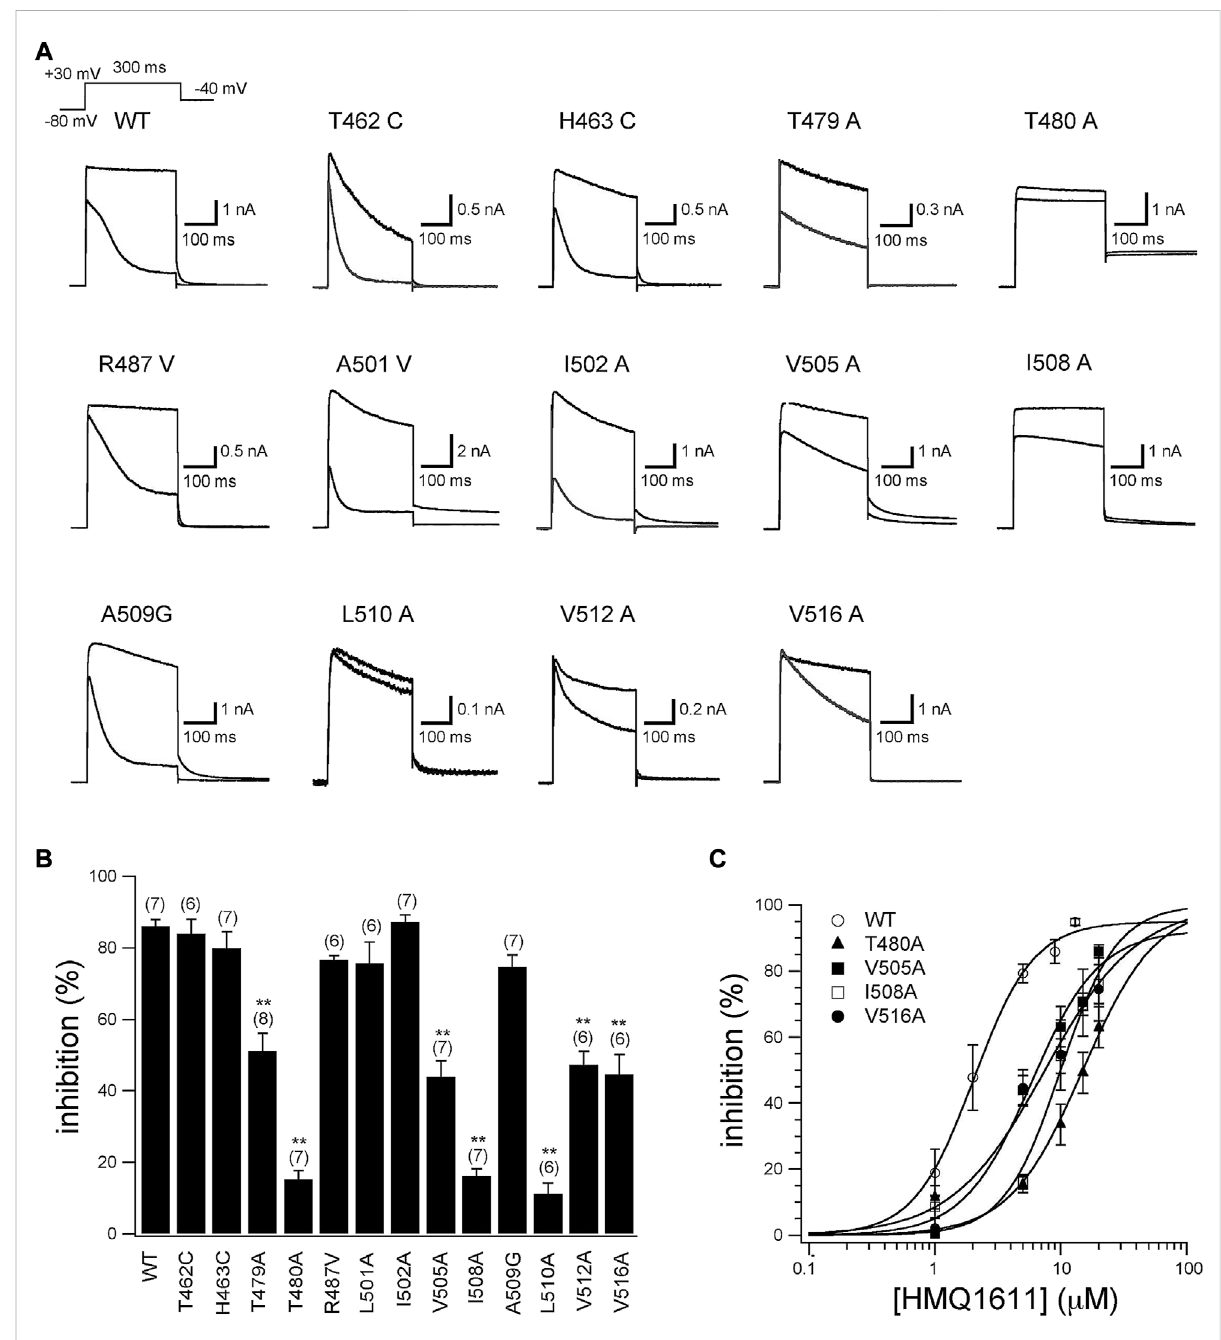
FIGURE 4 InhibitoryactionofHMQ1611onWTandthirteenhKv1.5mutantchannels. (A) Currenttracesrecordedfromwildtype(WT)and13hKv1.5mutant channels in CHO cells, using a 300 ms depolarizing step to +30 mV from a holding potential of -80 mV in the presence and absence of 5 μ M HMQ1611. (B) Percentage inhibition of WT and 13 hKv1.5 mutant channels by 5 μ M HMQ1611. Currents were measured at the end of 300 ms depolarizing pulse. Experiment numbers are shown in parenthesis. Data are demonstrated as mean ± SEM. ** p < 0.01 vs . WT. (C) Concentration-response relationship curves for HMQ1611 block of WT and hKv1.5 mutant channels (T480A, V505A, I508A, V516A) (six to eight cells in each channel). The solid lines represent a least-squares fi t of a Hill